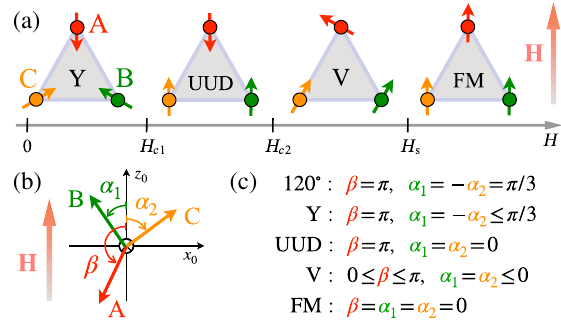
FIG. 4. (a) Schematics of the evolution of magnetic order with the field from the 120° state at H ¼ 0 to the Y phase, with the transition to the UUD plateau phase at H , from the UUD phase c 1 to the V phase at H , followed by a transition to the saturated FM c 2 phase at the saturation field H . The representative three- s sublattice spin structures are shown. (b) Angles of spins with the laboratory z 0 axis (field direction) for an arbitrary coplanar three-sublattice structure. Angles ˜ α ¼ f β ; α 1 ; α 2 g correspond to the α ¼ f A ; B ; C g sublattices. (c) Sets of ˜ α for all